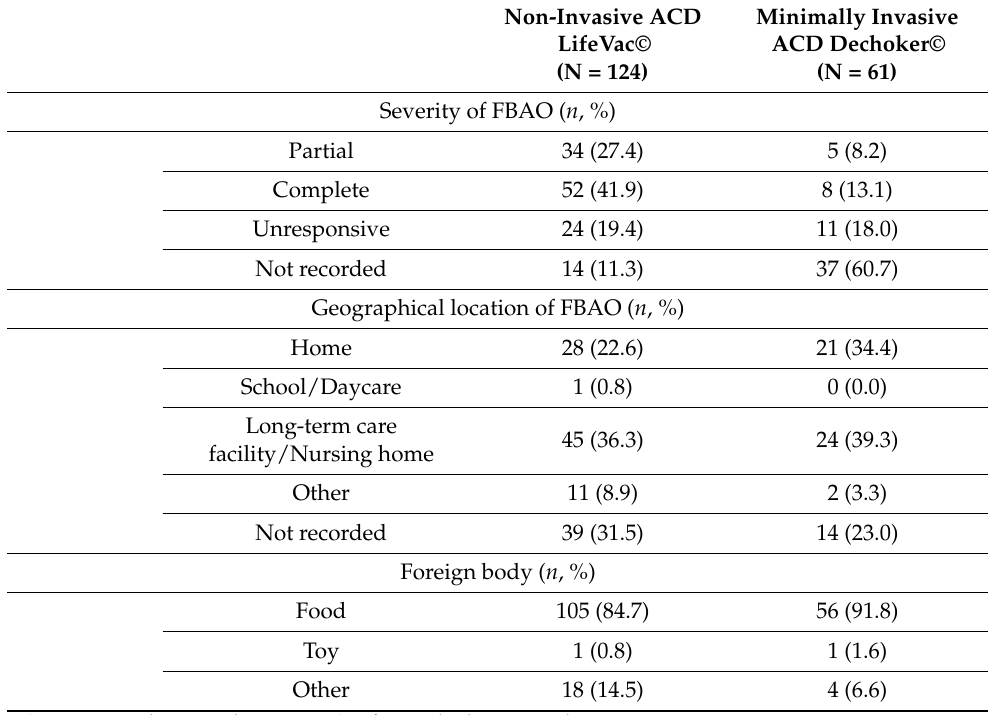
Table 2. Characteristics of the foreign body airway obstruction in patients intervened with an airway clearance